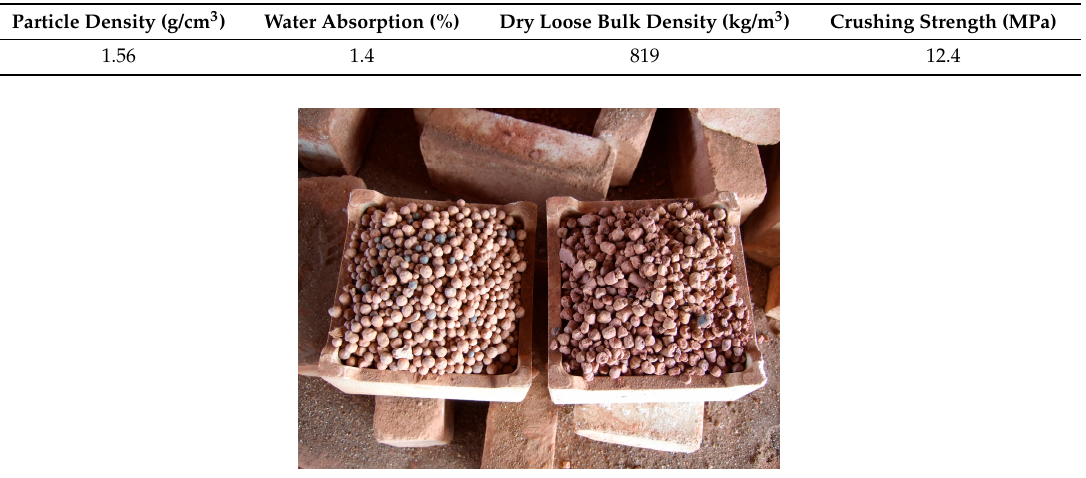
Table 17. Test results for high performance LWAs produced by the commercial tunnel kiln. Particle Density (g/cm 3 )